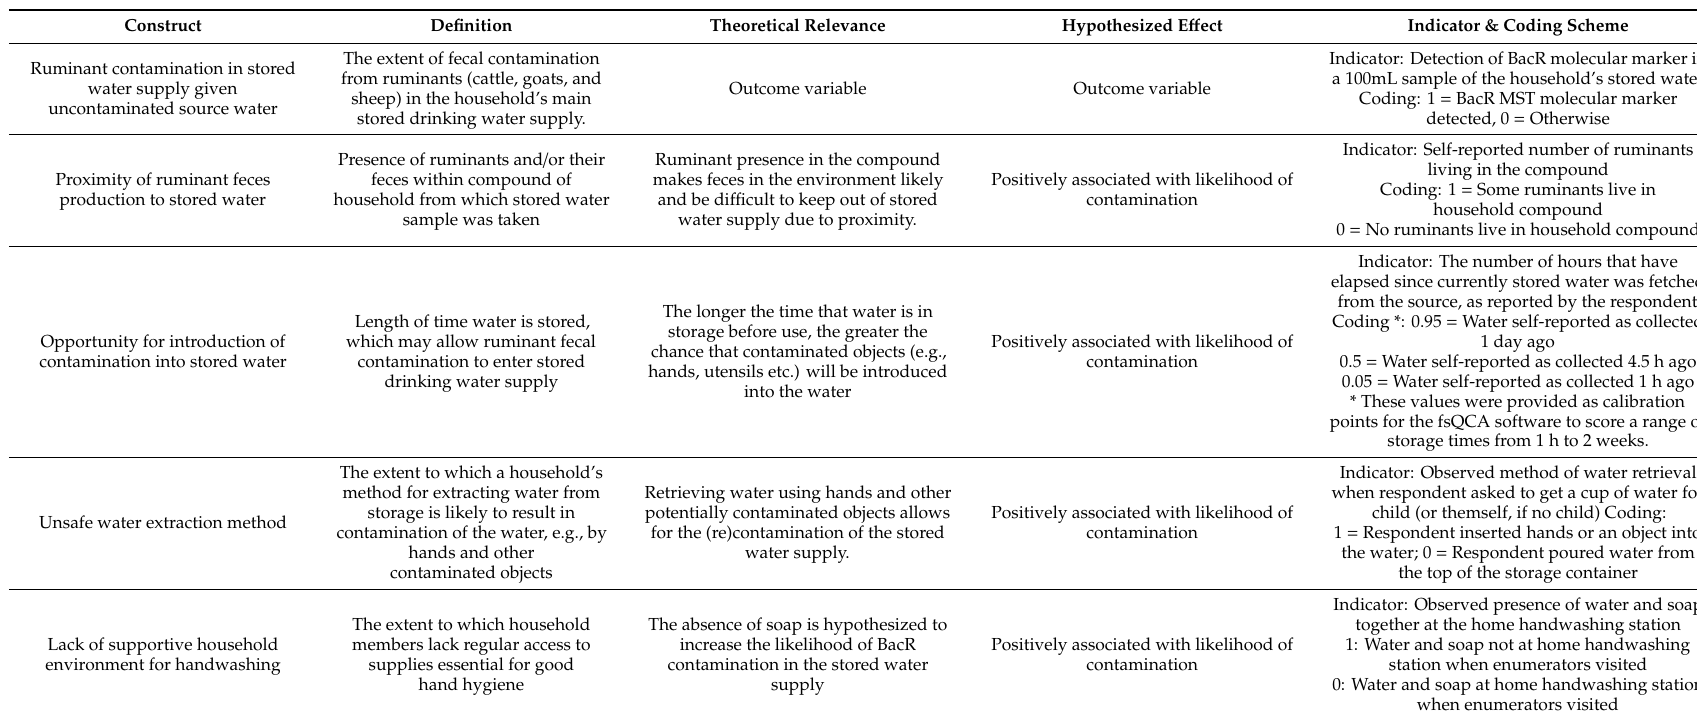
Table 1. Measurement Table and Summary of Indicators for